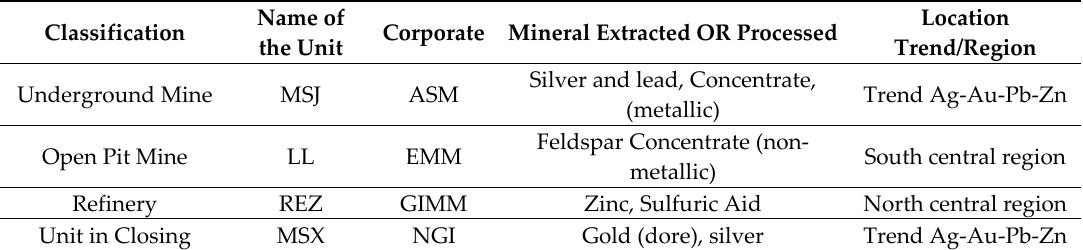
Table 3. Unit of analysis for the Multiple Integrated Case Study. Source: own elaboration.